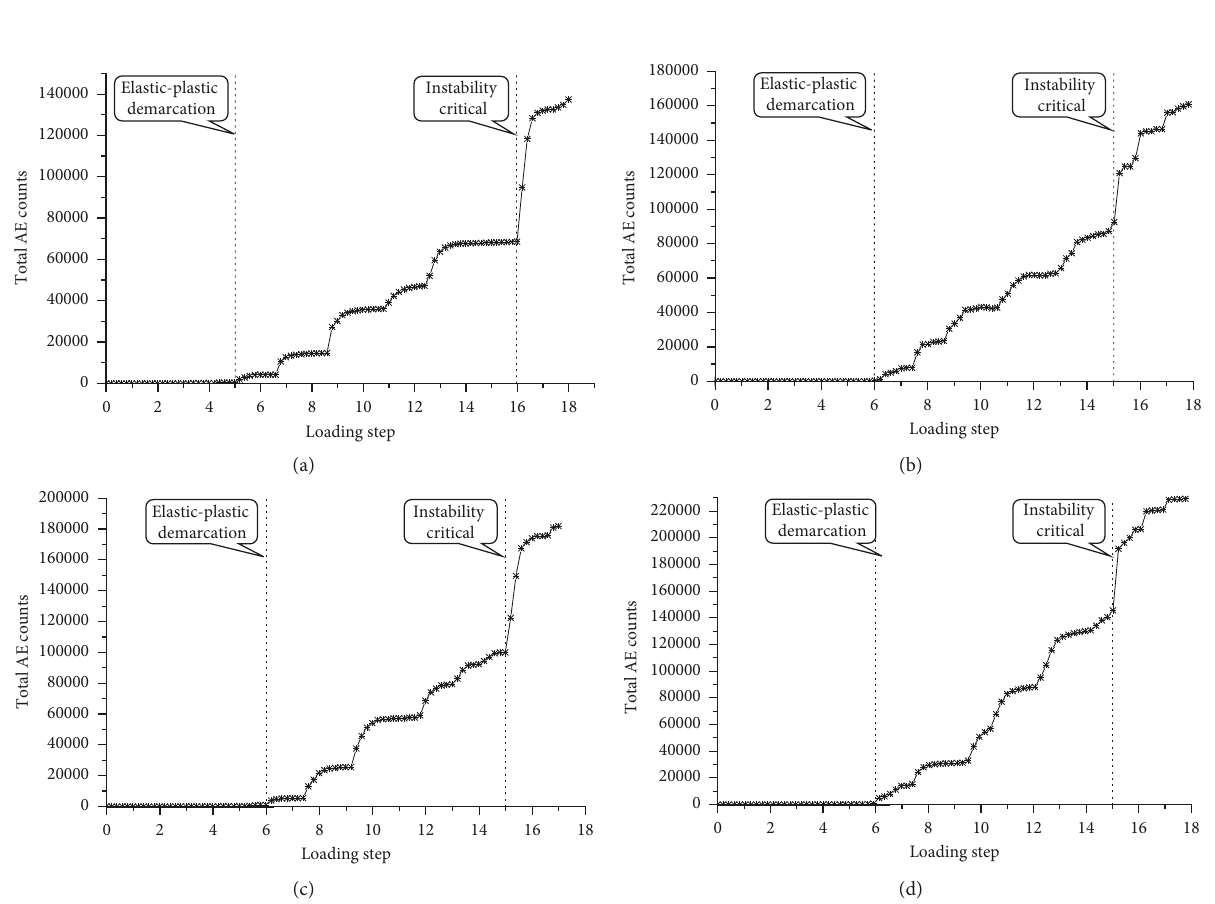
Figure 9: Segment AE test results. (a) Variation curve of acoustic emission for group 1. (b) Variation curve of acoustic emission for group 2. (c) Variation curve of acoustic emission for group 3. (d) Variation curve of acoustic emission for group